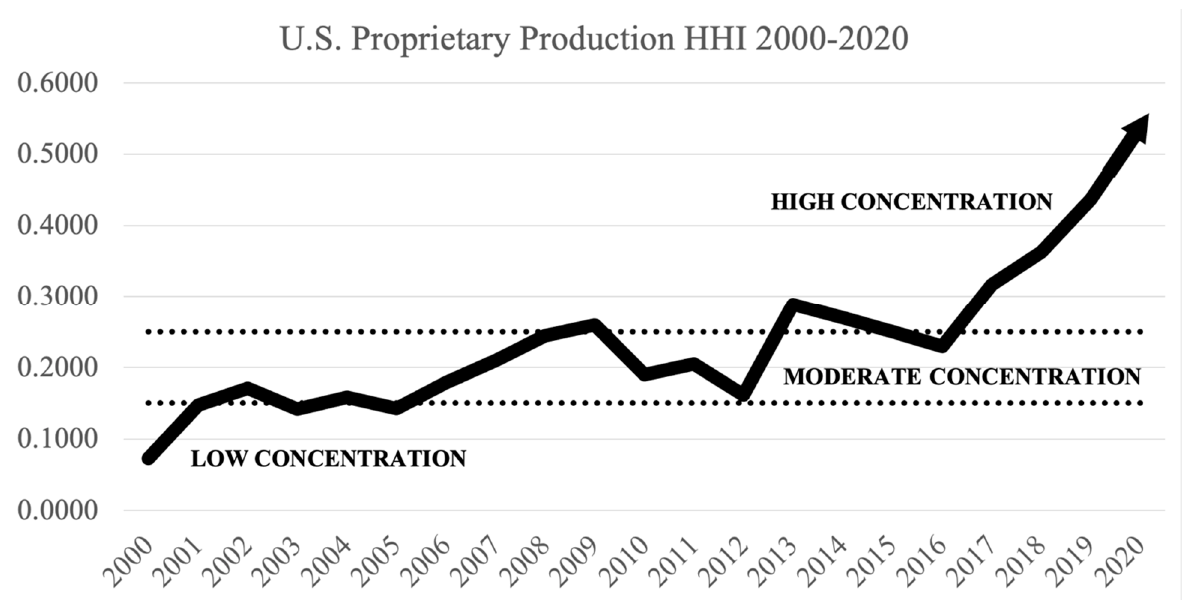
Figure 3. The HHI for total U.S. branded proprietary variety production 2000–2020 (own study based on [13]).